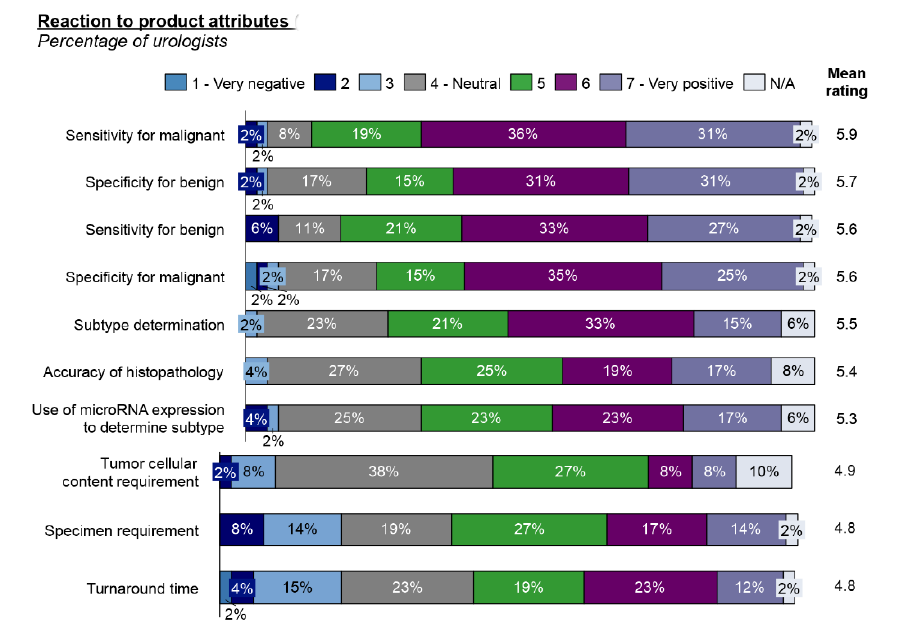
Figure 11. Test characteristics clinical favorability